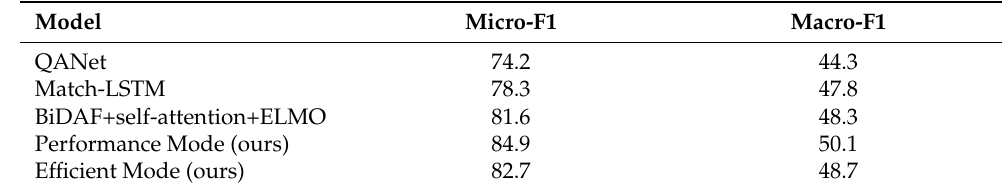
Table 4. Comparisons for different methods based on the CoLA dataset. Model